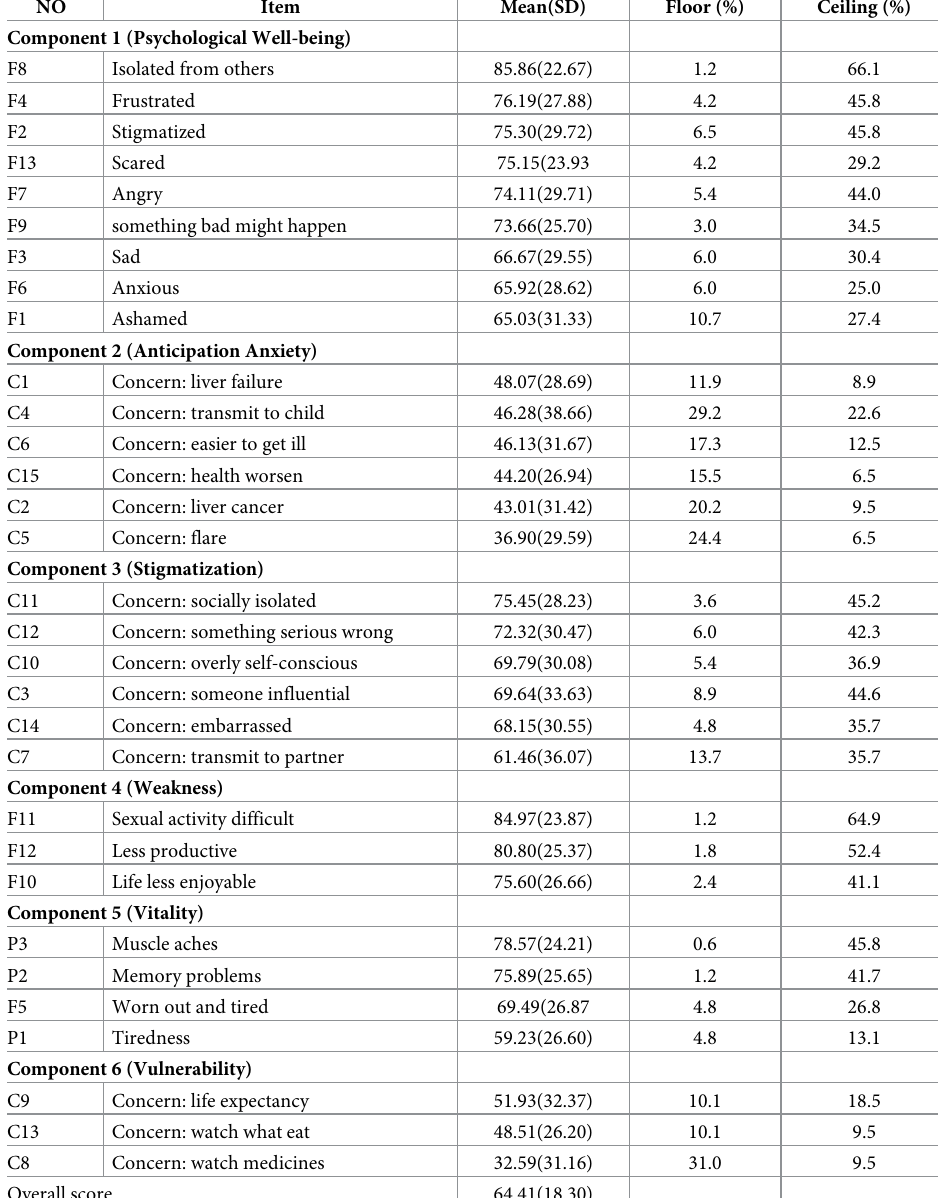
Table 4. Mean scores and floor and ceiling effects for each item (N =